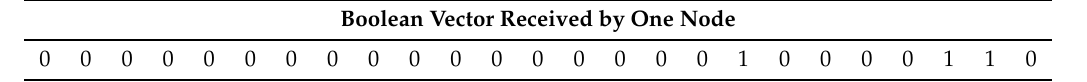
Table 12. Boolean vector obtained from the first row of Table 11 which contains 25 values corresponding to the 25 areas of the defined RoI.